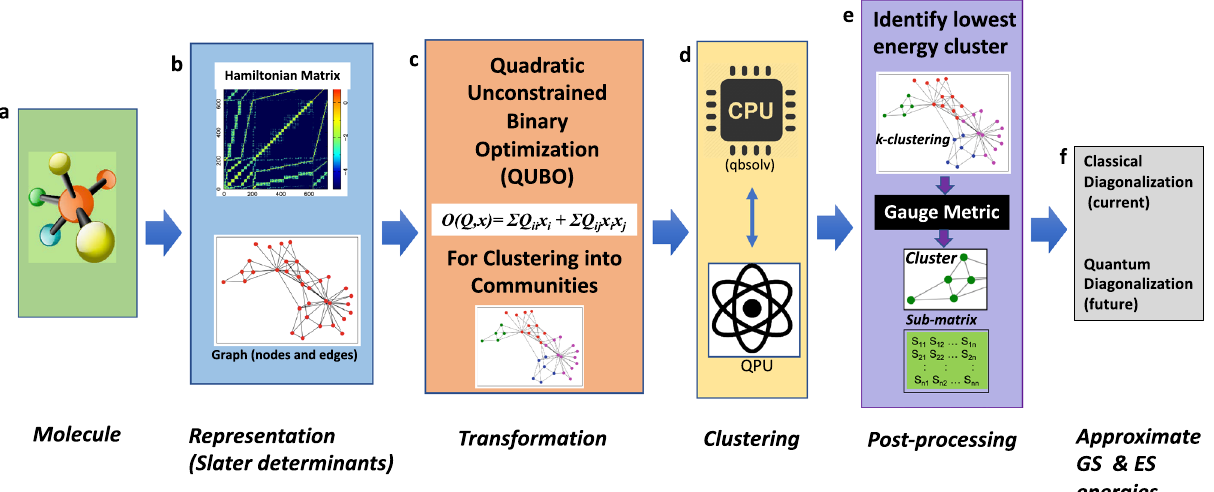
Figure 1. Conceptual workflow for the reduction process. ( a ) Cartesian co-ordinates for atoms, atomic numbers and a chosen basis set define a molecule. ( b ) An electronic Hamiltonian matrix is constructed in the basis of Slater Determinants (SDs) of spin-orbitals by using a classical quantum chemistry code. This matrix is further represented as a graph adjacency matrix where each SD is a node. ( c ) The graph is transformed to a Quadratic Unconstrained Binary Optimization (QUBO) form of Community Detection . ( d ) The QUBO is run using quantum-classical qbsolv + D-Wave quantum annealer. ( e ) The resulting clusters/communities as sub- matrices are candidates for the best low energy solution. The gauge metric is used to identify the lowest energy cluster. ( f ) Approximate ground state and excited state energies are calculated using